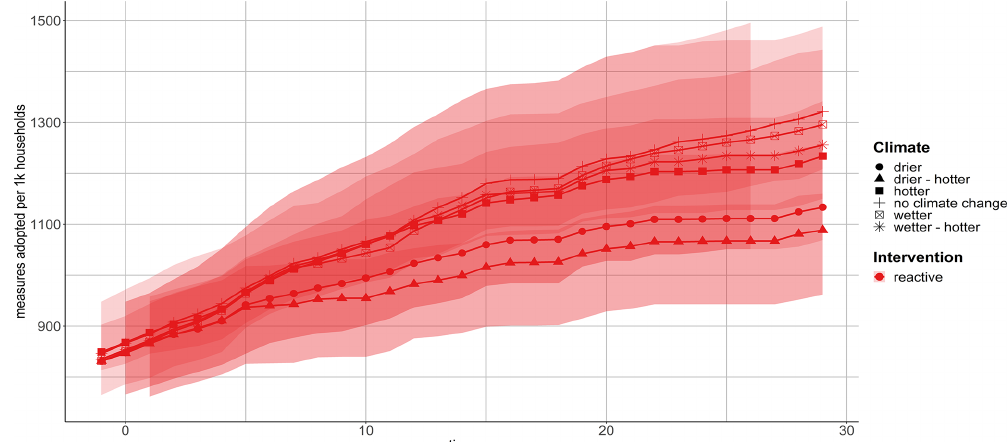
Figure B1. Total number of measures adopted per 1000 initialized households under the reactive scenario, averaged over all runs. The shaded area indicates the uncertainty introduced by different model initializations and by the different relative importance of the PMT factors for the decisions of households. Year 0 marks the initiation of the policy drought risk reduction intervention.